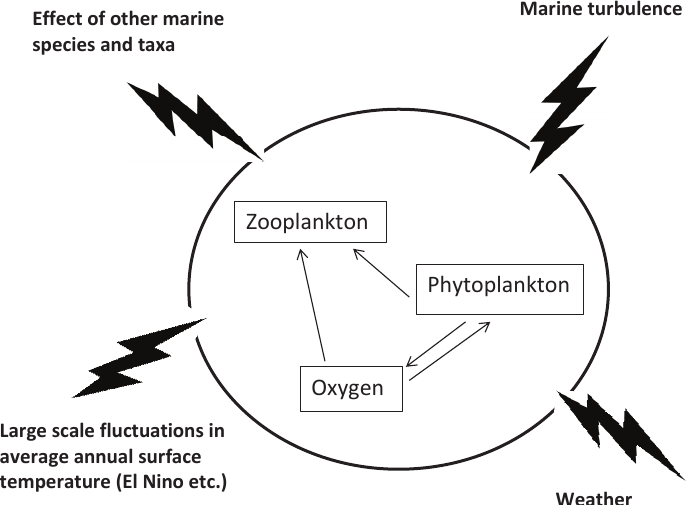
Figure 9. A sketch of oxygen-phyto-zooplankton dynamics affected by noise of different origins. Equations (26)–(29) with Equation (31) were studied by means of extensive numerical simulations. The numerical scheme was carefully checked and tested in order to avoid numerical